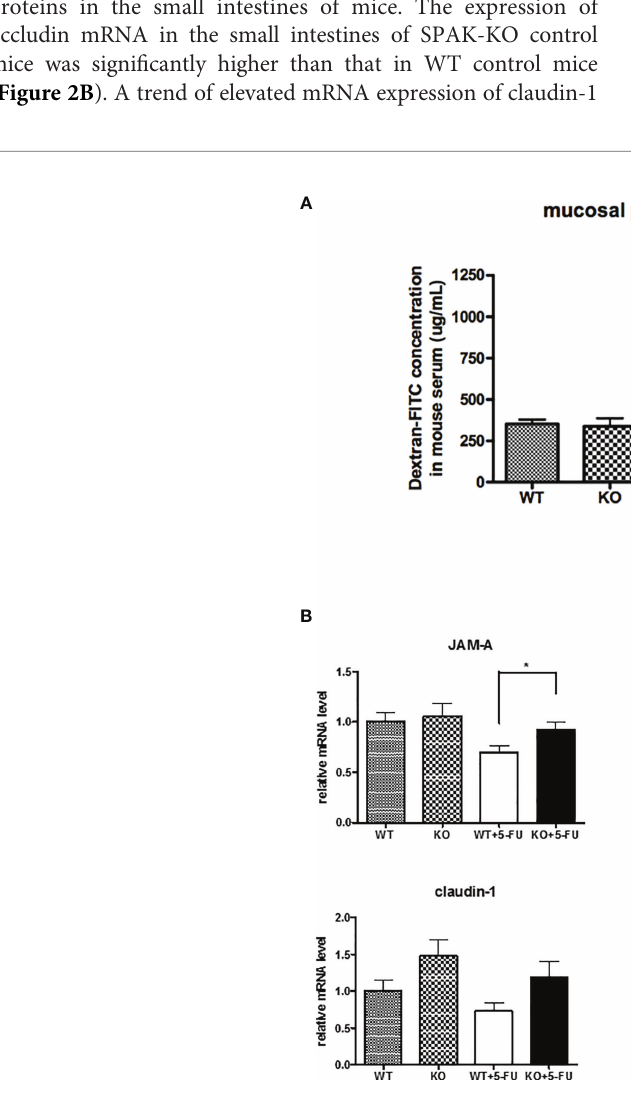
FIGURE 2 | SPAK de fi ciency attenuated the increased gut permeability and restored the downregulation of tight junction-associated proteins in the small intestines of mice with 5-FU-induced intestinal mucositis. (A) Gut permeability of WT and SPAK mice treated with 5-FU was determined by fl uorescein isothiocyanate (FITC)- labeled dextran assays (WT: n = 5, KO: n = 5, WT+5-FU: n = 6, KO+5-FU: n = 6). (B) Relative mRNA levels of tight junction-associated proteins in the small intestines of WT mice and SPAK-KO mice treated with 5-FU (WT: n = 9, KO: n = 9, WT+5-FU: n = 10, KO+5-FU: n = 10). Each point or bar represents the mean ± SEM; * P < 0.05 indicates differences between groups of WT mice that received 5-FU and SPAK mice treated with